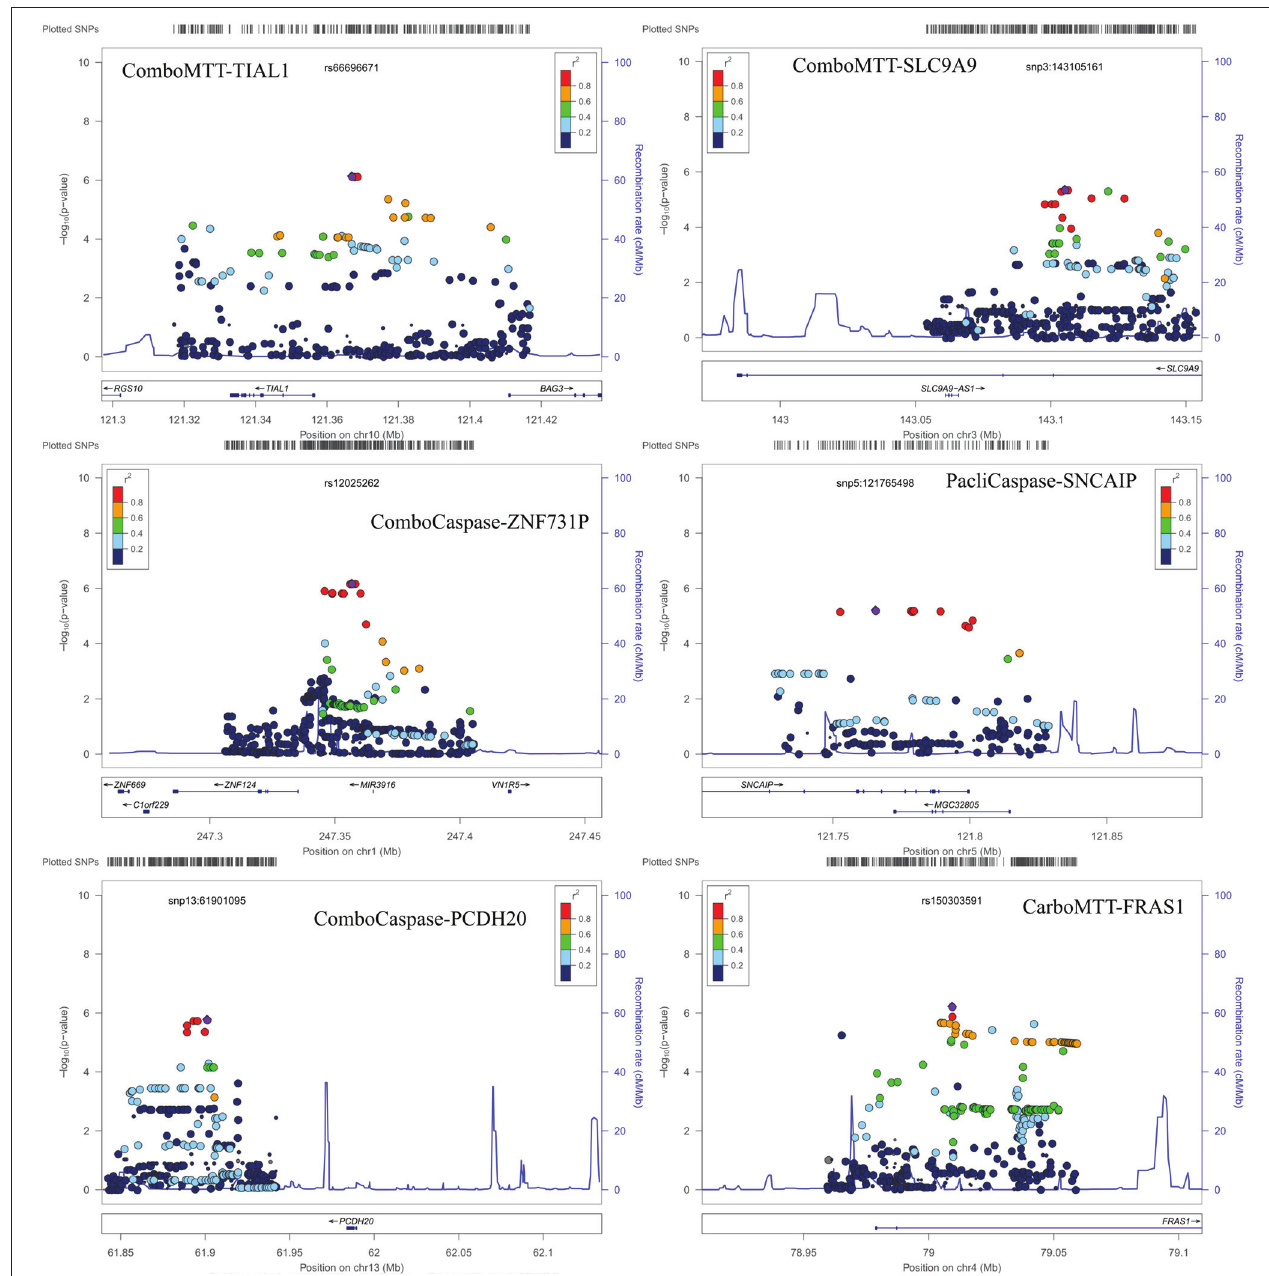
FIGURE 3 | Locus Zoom plots for regions with p < 10 − 6 . Note: BOD1L1 region not presented as only one SNP in region with p < 0.001.